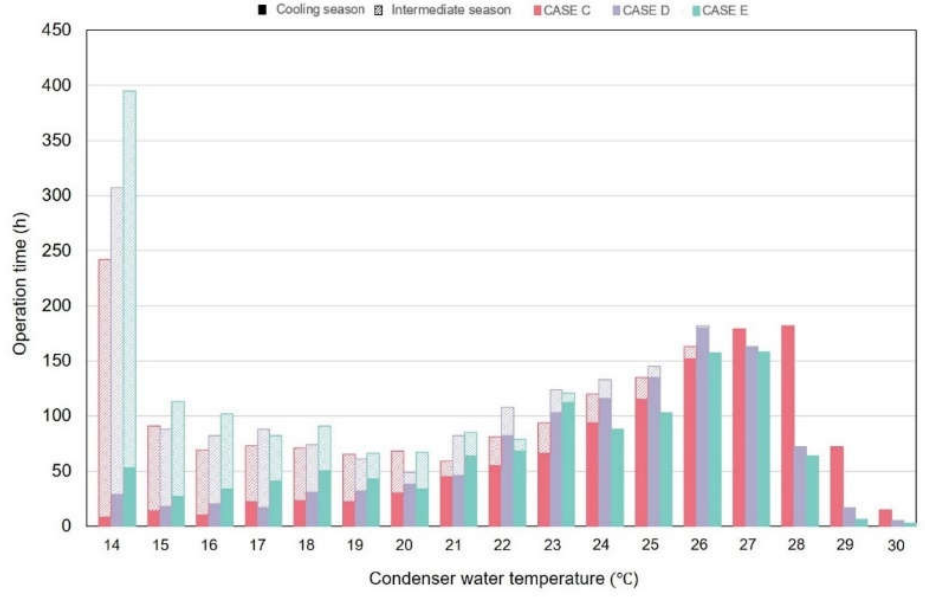
Figure 17. Annual operation hour of condenser water temperature for Case C–E.